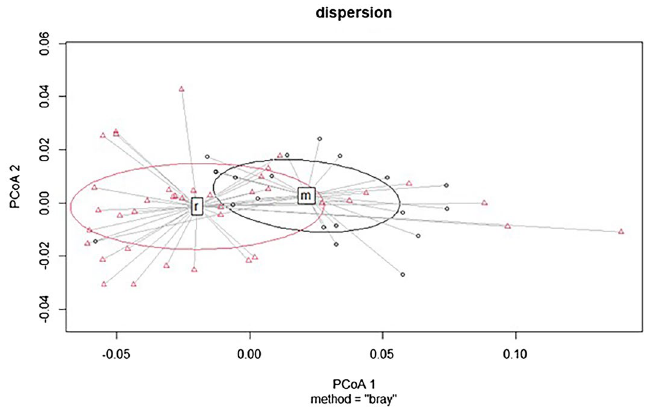
Figure 8. Differentiation of two mixed habitats using mean and max optical values (data from August 31, 2019), where the P value is less than 0.01. Abbreviations: m – 9130 – Asperulo-Fagetum beech forests and r – 9180 – Tilio-Acerion forests of slopes, screes, and ravines.